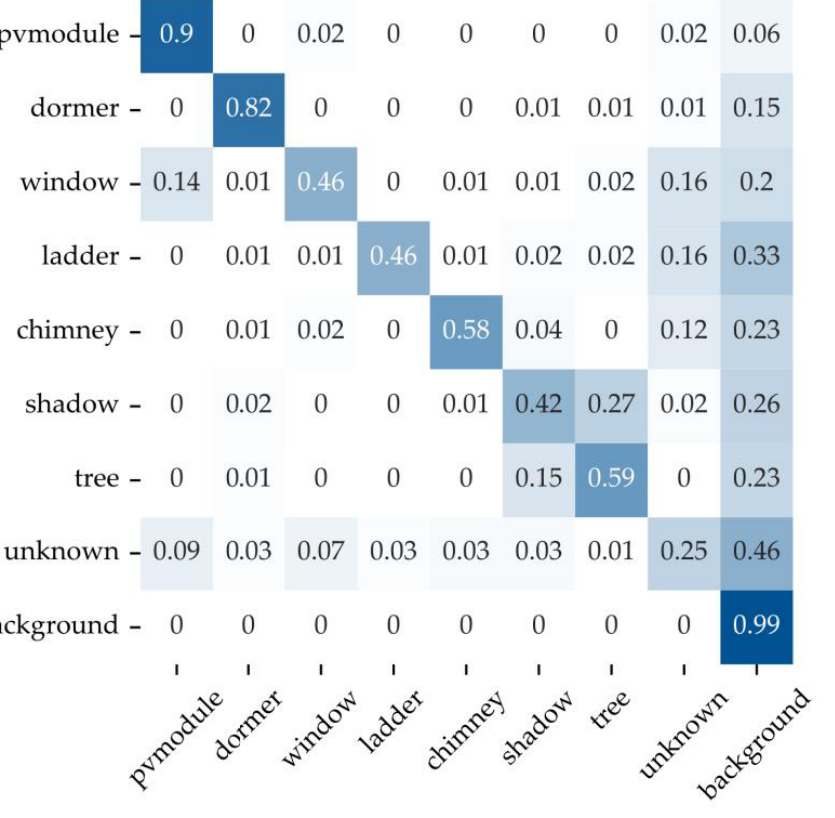
Figure 7. The overall confusion matrix normalized along its rows. Annotations are rounded to two digits. Hence, the row’s sum can be unequal to 1.